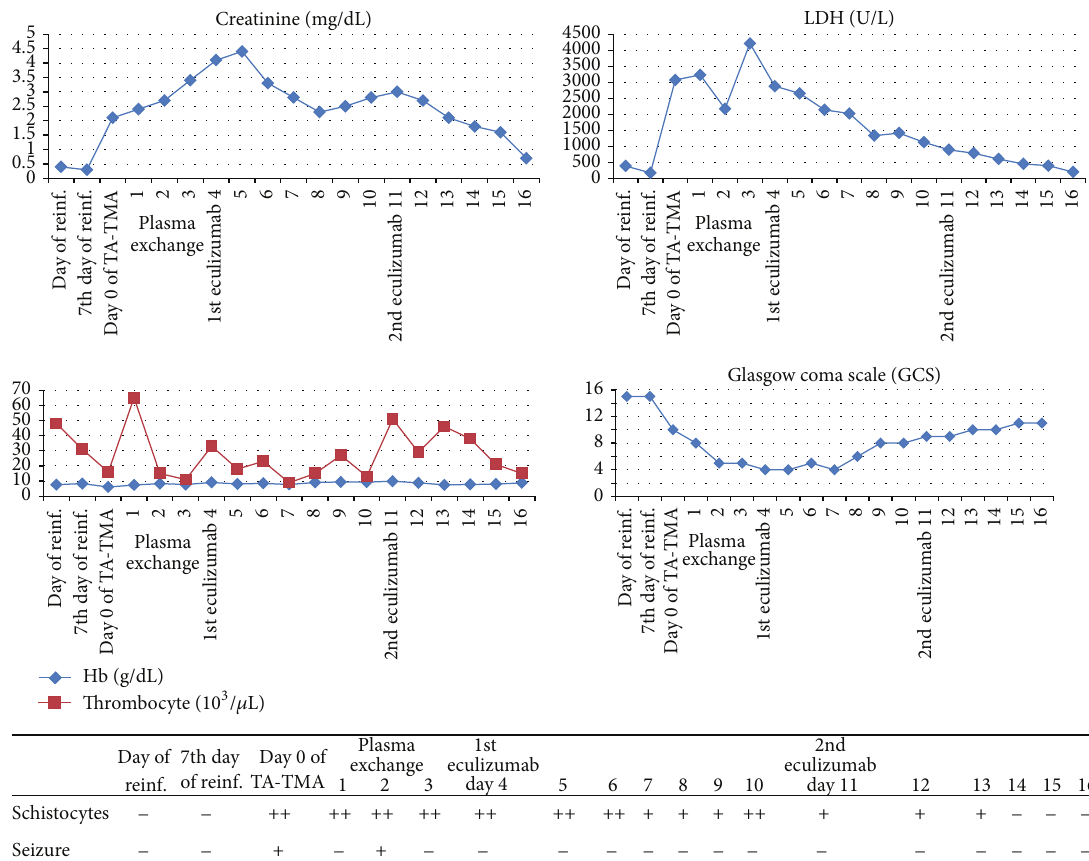
Figure 1: Clinical and biological response to eculizumab therapy. The figure shows data indicating neurological and renal improvement after administration of monoclonal C5 antibody eculizumab in our case with TA-TMA posthematopoietic progenitor cell transplantation with central nervous syprogenitor involvement. LDH levels were decreased dramatically, but thrombocyte count did not improve, possibly related to delayed hematopoietic